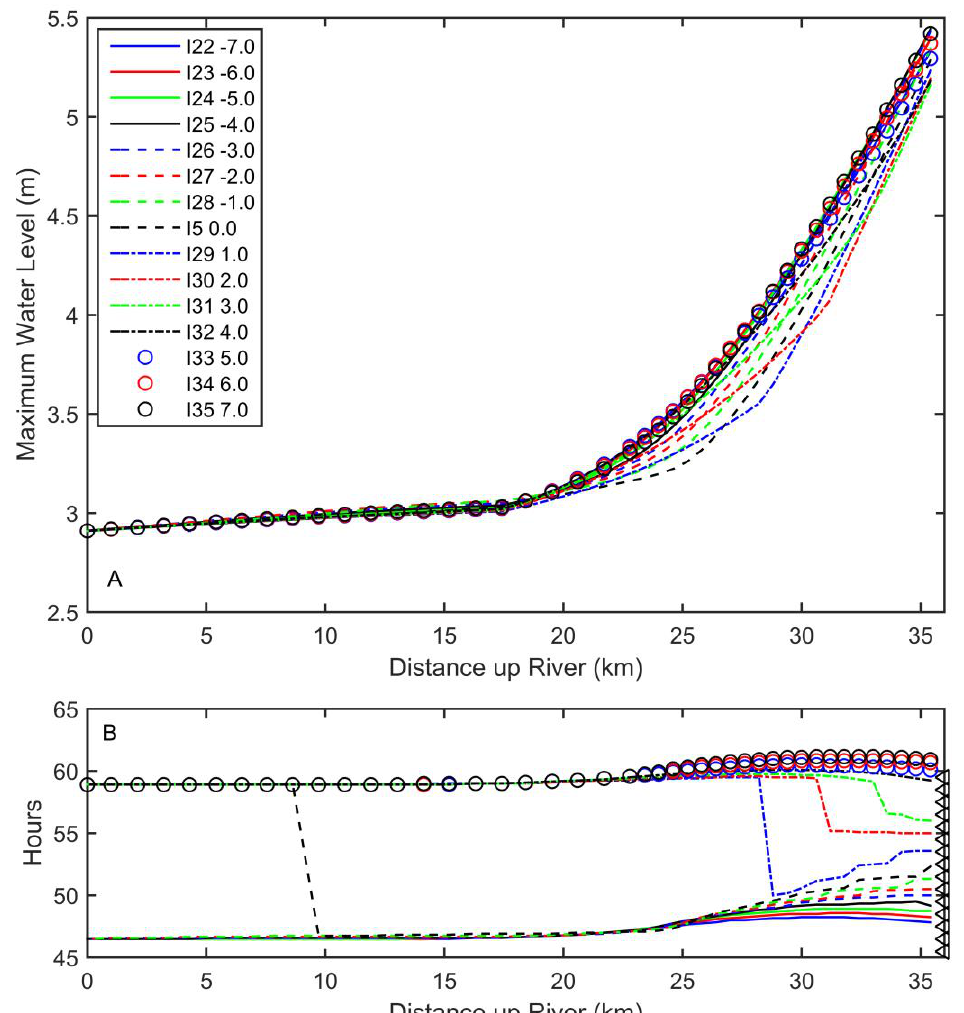
Figure 9. ( A ) Maximum water level along the river in cases with a 2-m M 2 tide and shifted discharge peaks. The legend indicates the hours of shift from the original discharge curve. ( B ) The time that the maximum water level occurs along the idealized river channel with triangles indicating the time of release at the head of the channel.